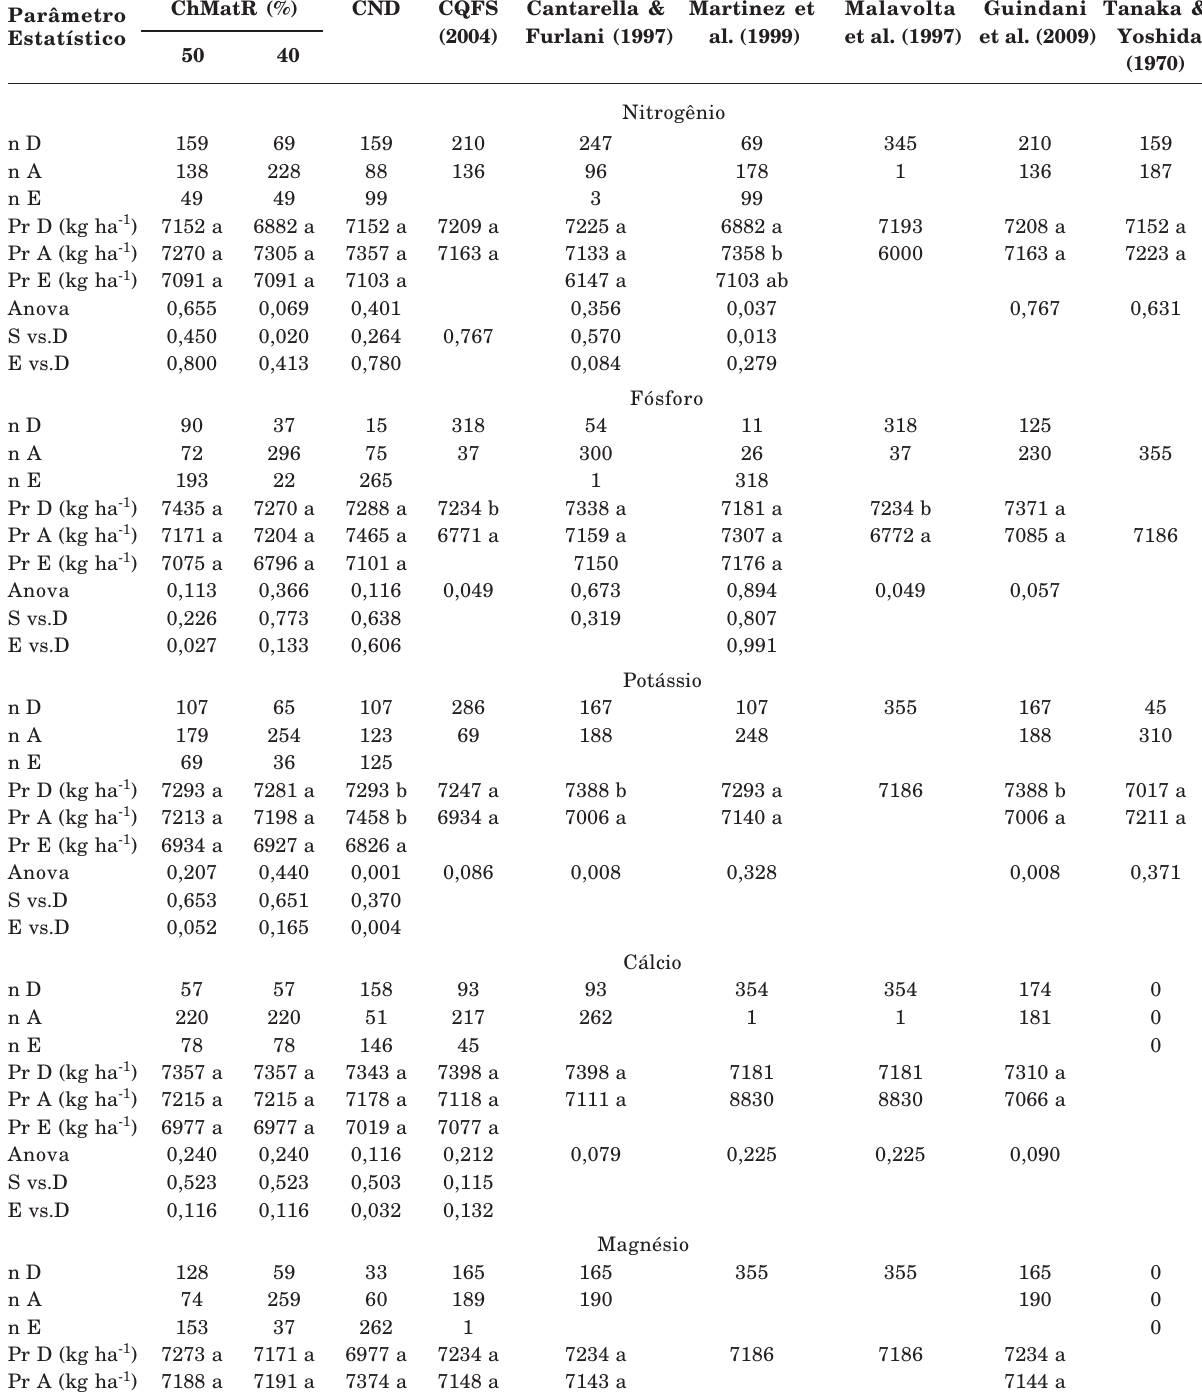
Quadro 3. Número de lavouras deficientes (n D), adequadas (n A) e com excesso (n E) de nitrogênio, fósforo, potássio, cálcio, magnésio e enxofre; produtividade média das lavouras deficientes (Pr D), adequadas (Pr A) e com excesso (Pr E), respectivamente para cada um desses nutrientes, e probabilidade da significância da análise de variância dos dados de produtividade das lavouras com diferentes disponibilidades de cada nutriente (Anova) e dos contrastes entre lavouras adequadas e deficientes (S vs. D) e entre lavouras deficientes e com excesso (E vs.D), em razão das faixas de suficiência